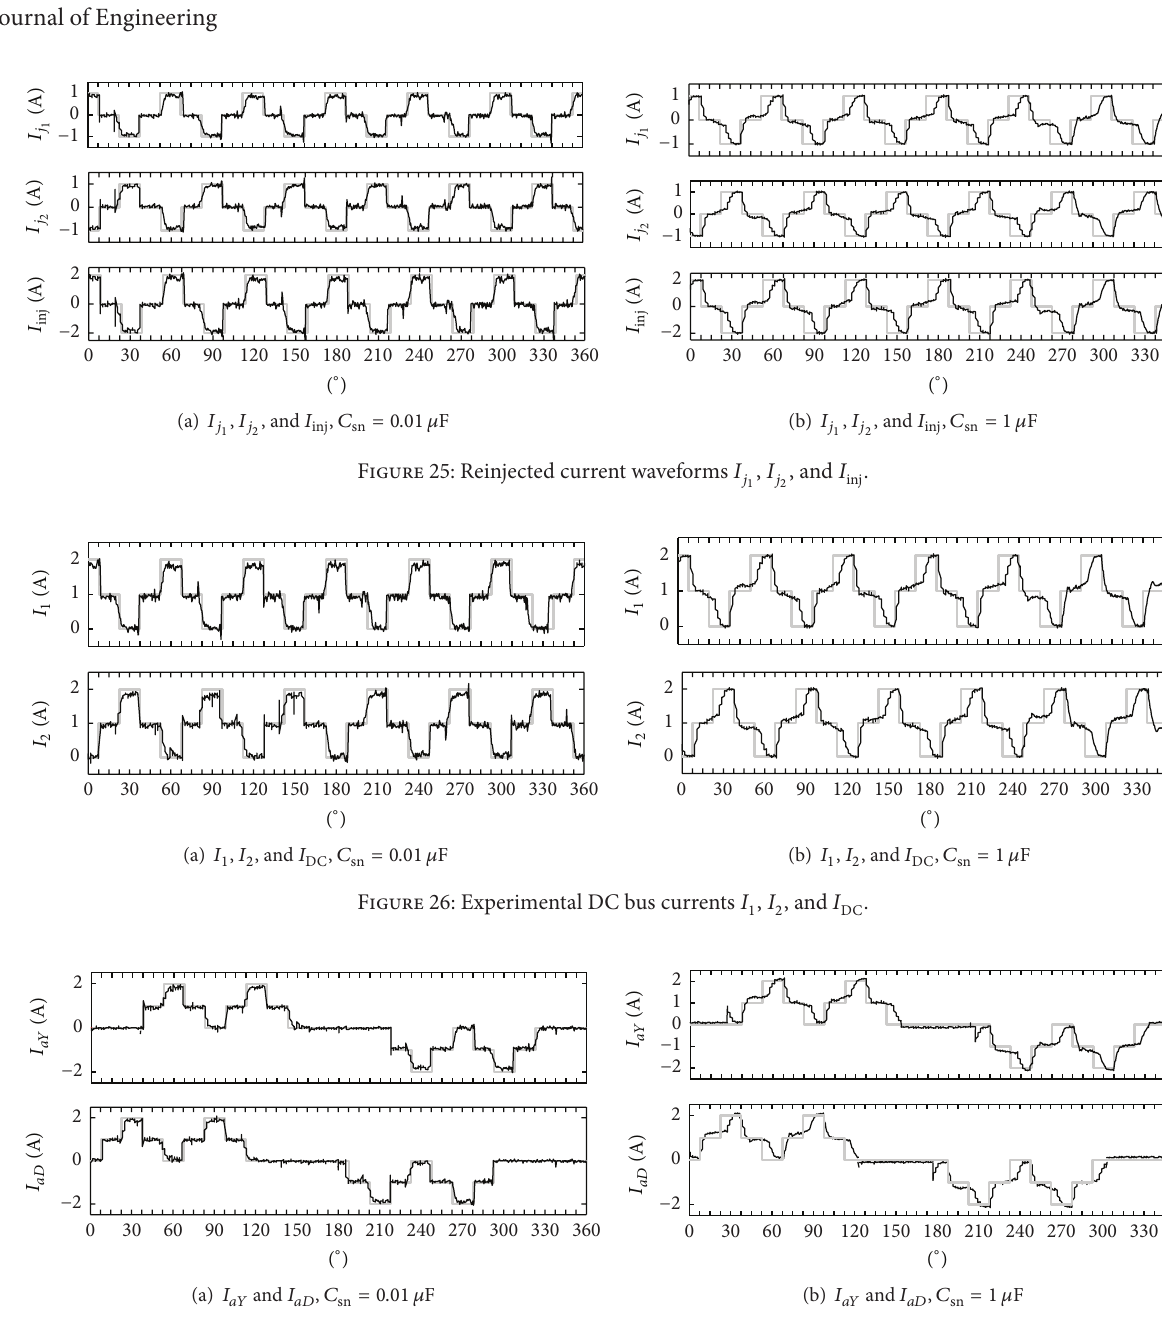
Figure 27: Secondary side line currents 𝐼 𝑎𝑌 and 𝐼 𝑎𝐷